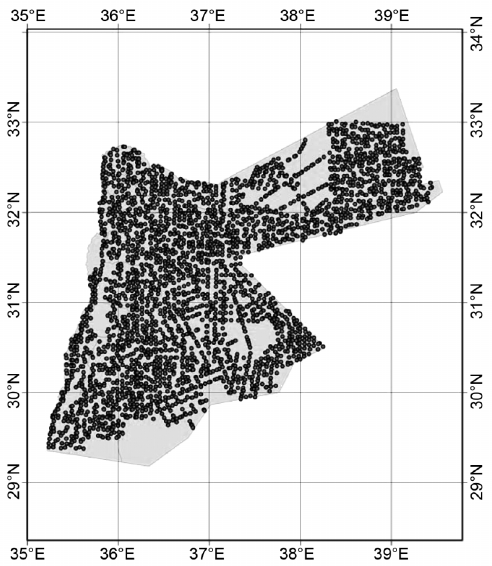
Fig. 2. Gravity data distribution over Jordan territo- ry (latitude and longitude in WGS84).